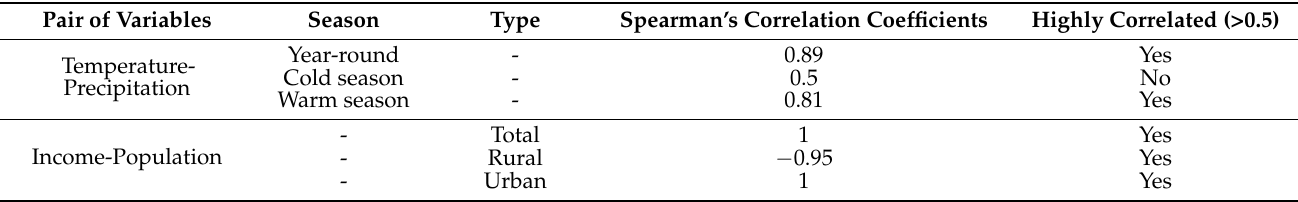
Table 1. Results of Correlation Tests for the Tibet